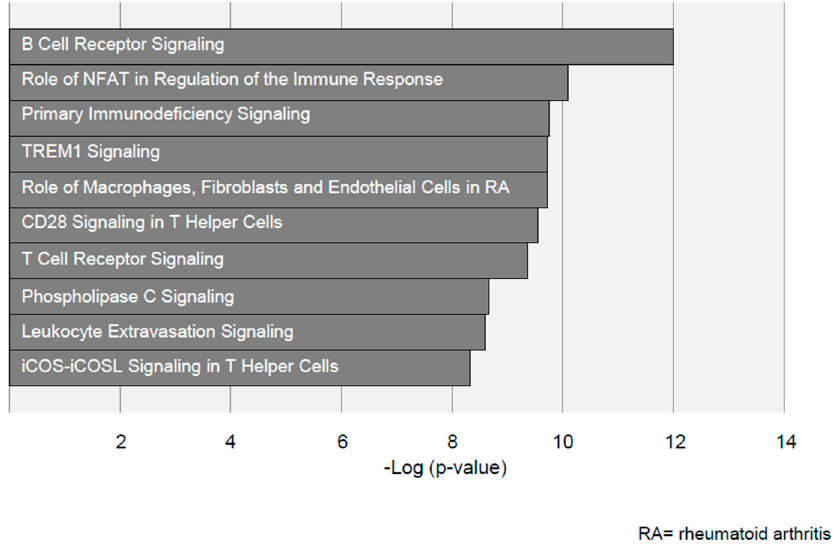
Figure 4. List of the top 10 significantly upregulated pathways in AAA disease identified with Ingenuity Pathway Analysis (IPA). The –log( p ) value depicted on the x-axis represents significance of the depicted pathways.